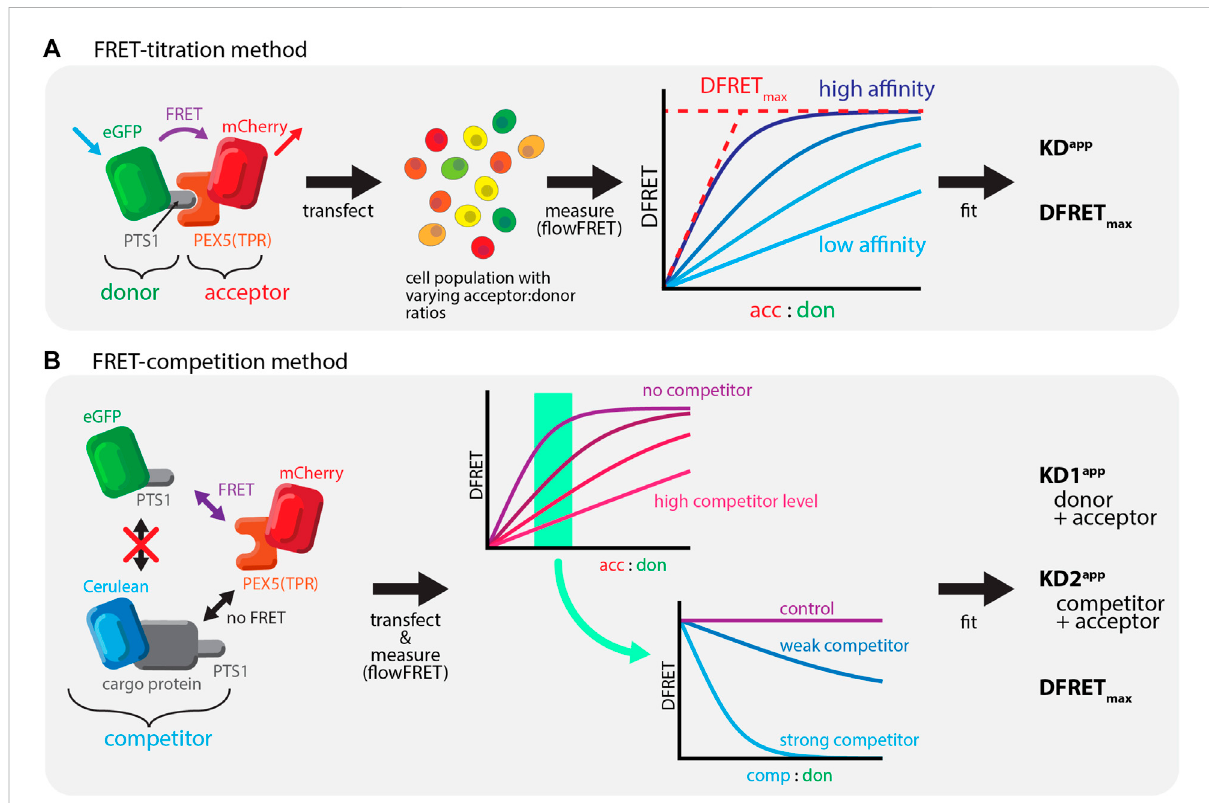
FIGURE 1 Studying PEX5-cargo interactions using FRET-measurements: (A) Bimolecular FRET measurements: left : FRET as radiation free energy transfer between fl uorescent proteins in close proximity is used to measure the interaction between mCherry-extended by the TPR-domain of PEX5 (PEX5 (TPR)) and EGFP equipped with a PTS1; middle : a large number of cells expressing these proteins are systematically investigated using a fl ow- cytometer, right : saturation curves can be obtained by plotting the acc:don ratio against a measure of energy transfer ef fi ciency (DFRET), in which the slope re fl ects the af fi nity and the saturation level the distance of the fl uorogenic centers; (B) Competition based FRET experiments: left : when studying a de fi ned FRET-pair (mCherry-PEX5(TPR) and EGFP-PTS1) the presence of a third protein also interacting with the acceptor (Cerulean-cargo-PTS1) exertsacompetitiveeffect; middle :whenplotting asaturation curve(acc:don) an increasing amount ofcompetitor changes itsshapeto suggestareductionoftheinteractionstrength oftheFRET-pair(minor slope)inadose dependent manner; right :plottingDFRET against the competitor to donor ratio (comp:don) results in traditional decay curves, in which the slope of the decay re fl ects the relative af fi nity of the competitor (to the